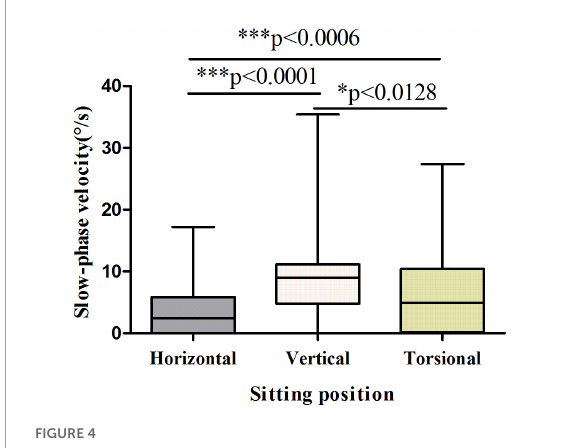
FIGURE4 Slow-phase velocity of nystagmus in the sitting position of patients with PSC-can. The slow-phase velocity of nystagmus differed significantly between the horizontal and vertical components ( p < 0.0001), horizontal and torsional components ( p < 0.0006), vertical and torsional components ( p < 0.0128). ∗ p < 0.05, ∗∗ p < 0.01, and ∗∗∗ p < 0.001, compared with respective control.